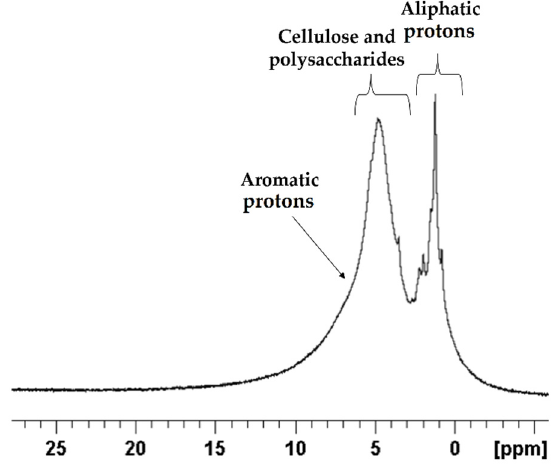
Figure 6. 1D 1 H spectrum of E. foeminea plant powder recorded using 600 MHz solid-state NMR. The spectrum obtained verified the 13 C results, where the δ 10 to 3 ppm mid-field sug-